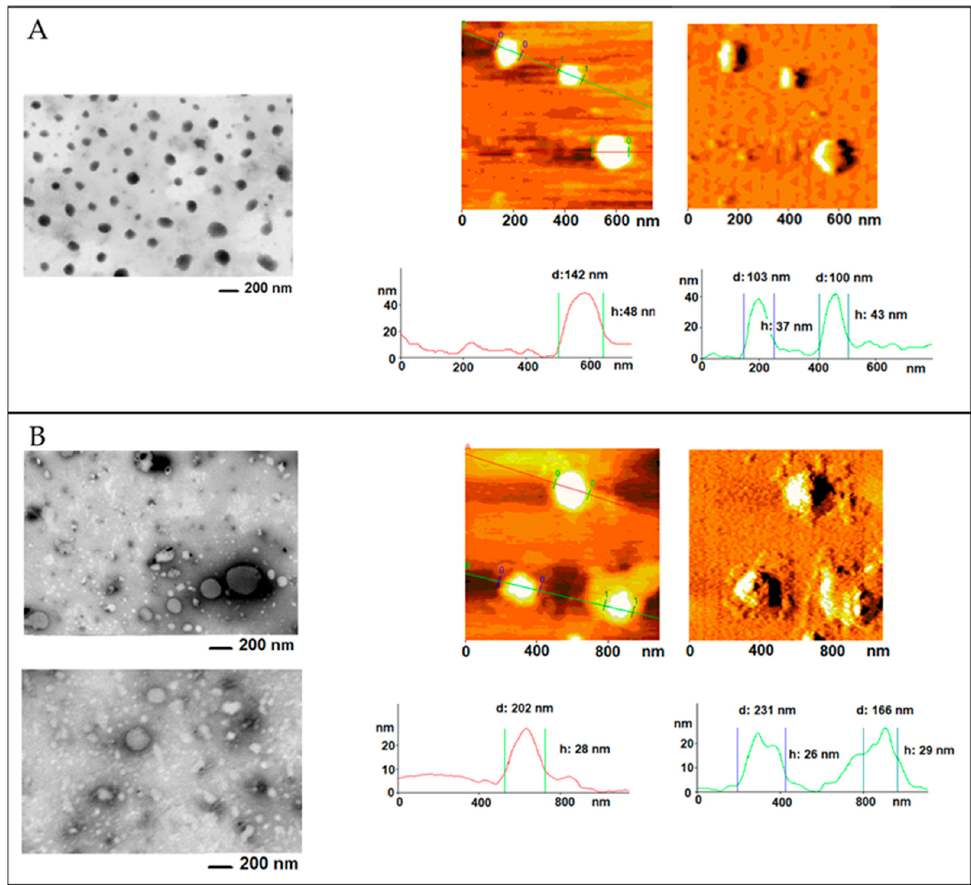
Figure 4. Microscopy images of H-NMeds produced via ( A ) nanoprecipitation or ( B ) the microfluidic device. Left panels: STEM imaging. Right panels: AFM imaging, topography, and error signal.